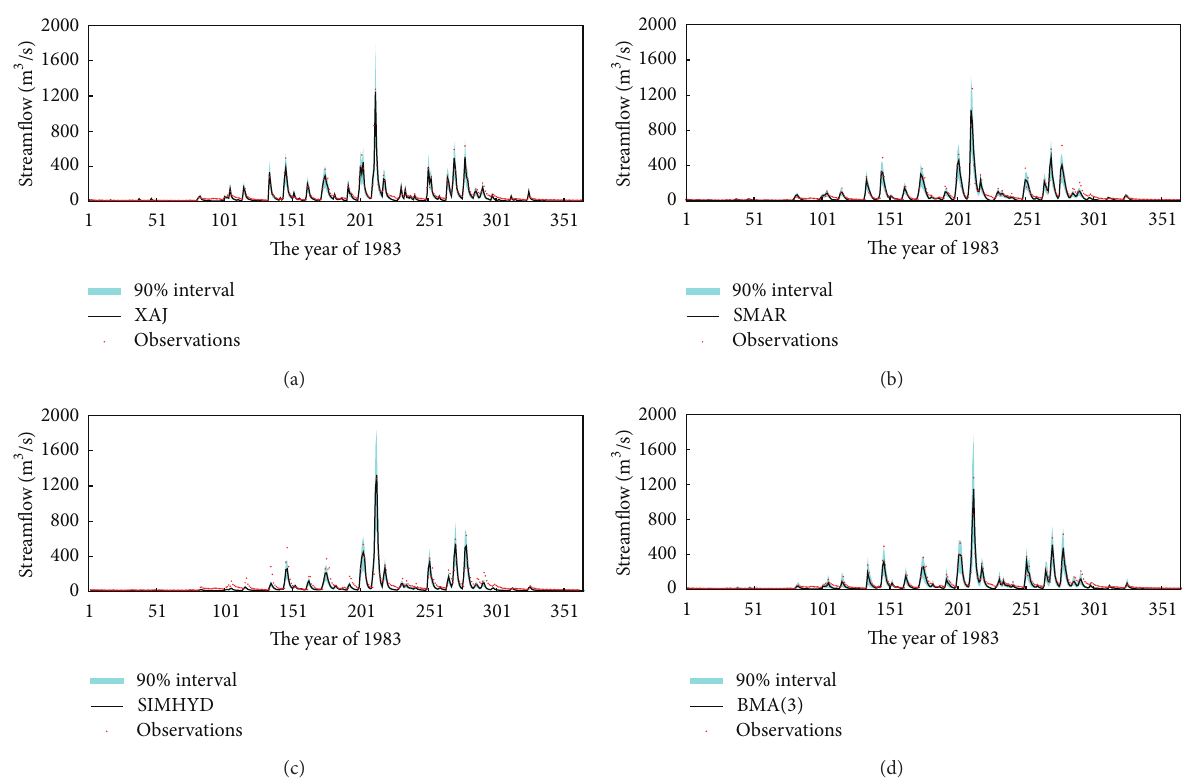
Figure 6: The mean prediction and 90% uncertainty interval of both BMA(3) and 3 individual models for the Mumahe catchment in 1983 during the calibration